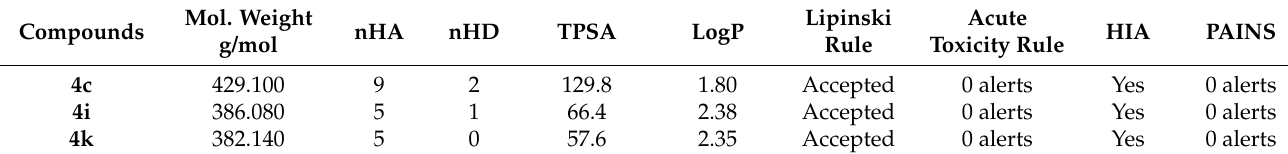
Table 2. In silico predicted ADMET properties of spirooxindole analogs. Table 4. In silico predicted ADMET properties of spirooxindole analogs.